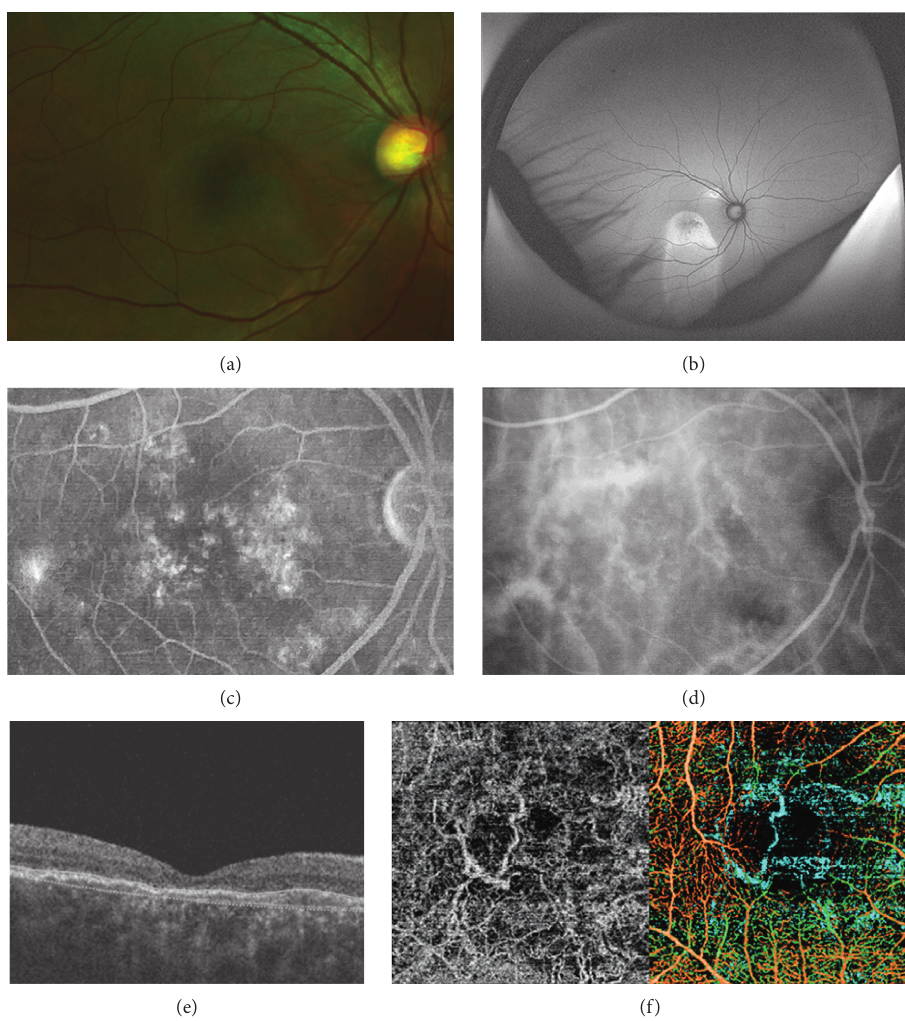
Figure 4: Application of multimodal imaging in assessment of central serous chorioretinopathy. (a) Fundus photograph reveals change in the retinal pigment epithelium (RPE) layer. (b) The extent of the RPE layer change is more prominent with the fundus autofluorescence. (c) Fluorescein angiography demonstrates staining pattern of hyperfluorescence without active leakage. (d) Underlying choroidal hyperfluorescence is shown with indocyanine green angiography. (e) Although no subretinal fluid or pigment epithelial detachment is found, choroidal neovascularization is noted at the choriocapillaris layer (f), which is colored blue in the composite optical coherence tomography